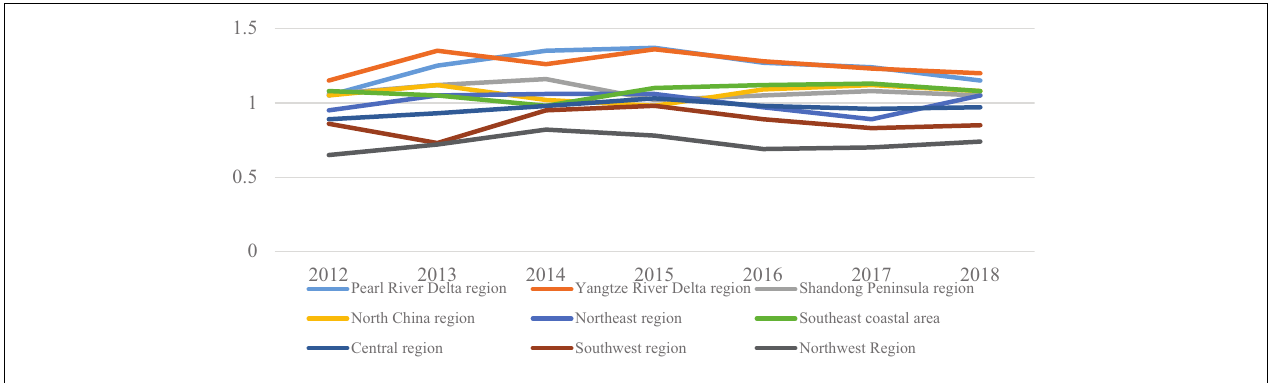
FIGURE 4 | Location entropy of the logistics industry in the nine major logistics